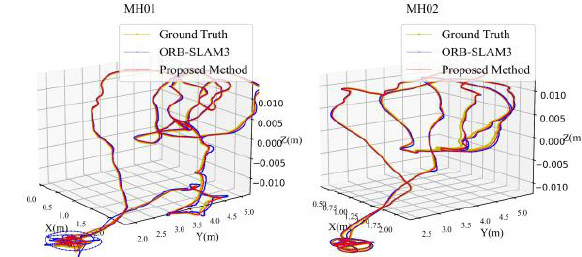
Figure 2. Frame trajectories in the stereo-inertial mode.